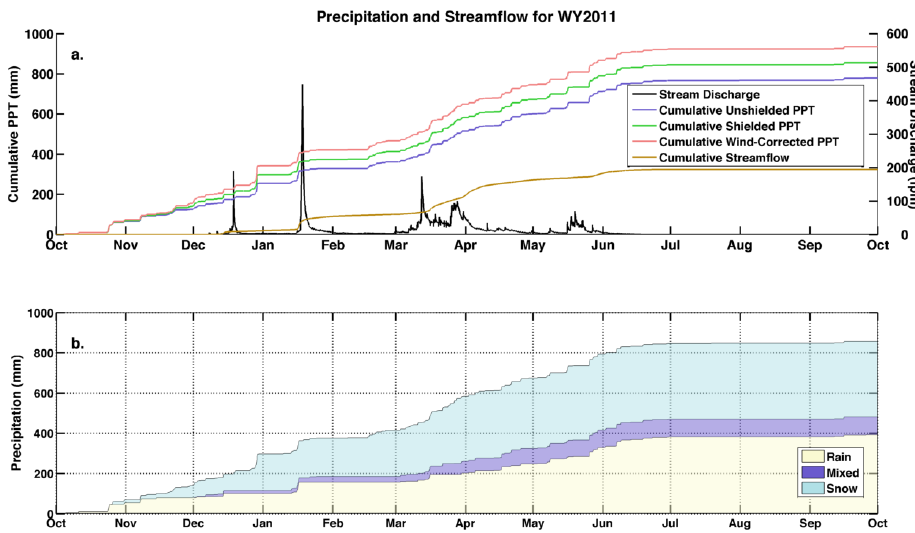
Figure 2. Precipitation and streamflow from the Treeline experimental catchment for WY2011. Cumulative shielded, unshielded, and wind- corrected precipitation with cumulative streamflow and the hydrograph are presented in (a) . The phase of cumulative wind-corrected precip- itation based on dew point temperature is presented in (b) .